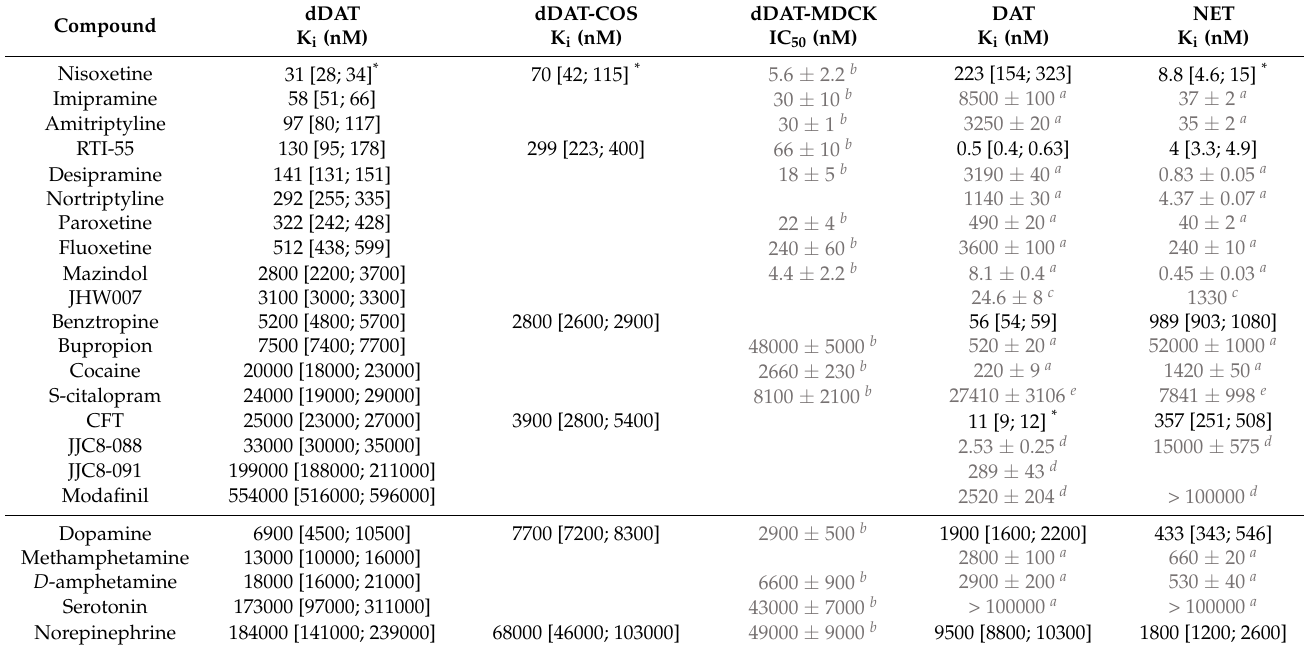
Table 1. Pharmacological characterization of purified dDAT and comparison with dDAT in whole cells (dDAT-COS and dDAT-MDCK) and other monoamine transporters. K i values were determined from competitive inhibition of [ 3 H]nisoxetine binding to purified dDAT. K i values were determined from competitive inhibition of [ 3 H]nisoxetine binding to dDAT and hNET in COS-7 cells or [ 3 H]CFT binding to hDAT in COS-7 cells and compared to the IC 50 values determined for dDAT transfected into MDCK cells (dDAT-MDCK; grey; b .) [25], as well as K i values from the literature (cited below; light grey). ”DAT” and ”NET” represent mammalian DAT and NET as some of these compounds have not been investigated on the human monoamine transporters. Competitive inhibition curves for purified dDAT from which all K i values were acquired can be found in Figure 1a, Figure 3b and Supplementary Figure S2. Competitive inhibition curves established in-house for dDAT, hDAT and hNET in whole cells can be found in Figures 4 and 5. The IC 50 values from dDAT-MDCK should be comparable to the K i values as [ 3 H]dopamine was used at concentrations < 10% of its respective K m values. ∗ represents K d values for [ 3 H]ligand binding to purified dDAT or the monoamine transporters expressed in COS-7 cells determined by saturation binding or homologous competitive inhibition, respectively. All values in grey have been taken from previous literature. Data shown as means ± SEM or [SEM interval].